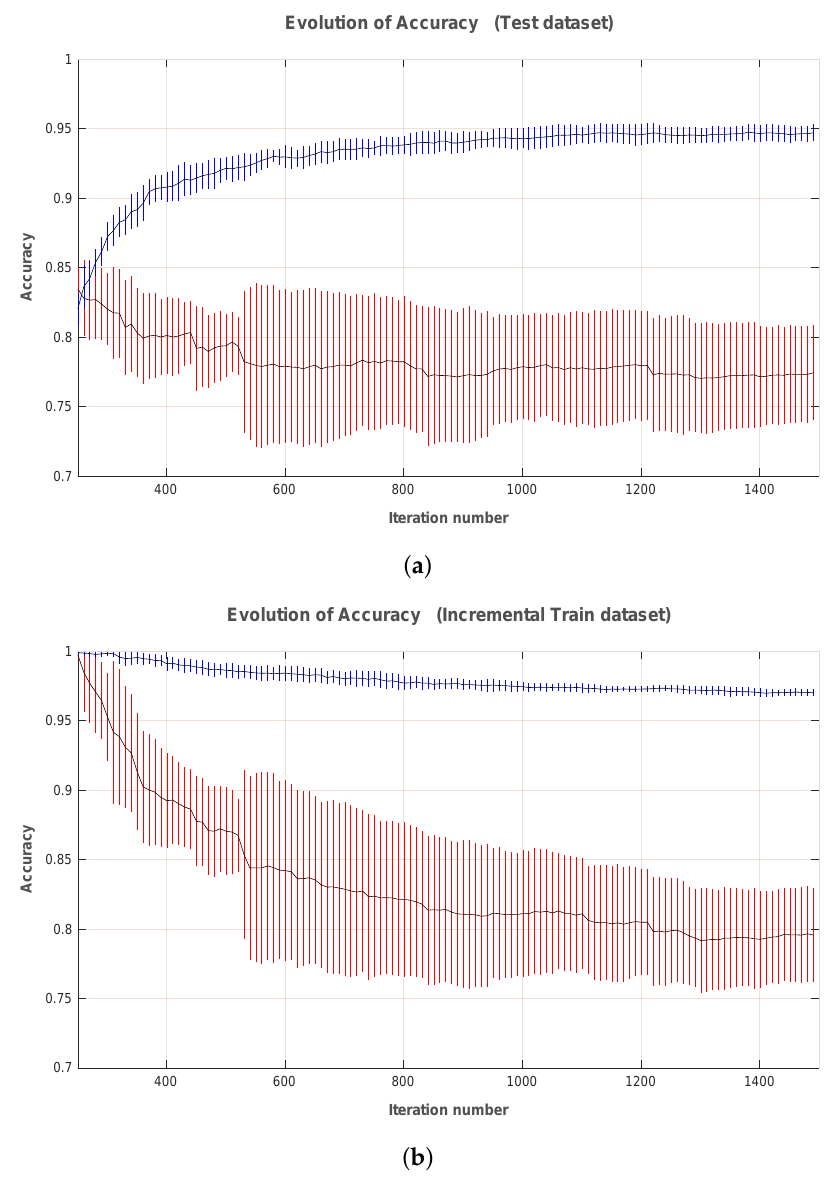
Figure 2. Evolution of the Accuracy of the SLFN neural network as it is sequentially trained using the OS-ELM algorithm under FPGA hardware implementation in single (red) and double floating point precision (blue). Both figures show how the Accuracy changes iteration to iteration. In ( a ) validation is performed using the Test dataset in each iteration, while ( b ) performs the validation on an incremental training data set (the portion of Train dataset used until each